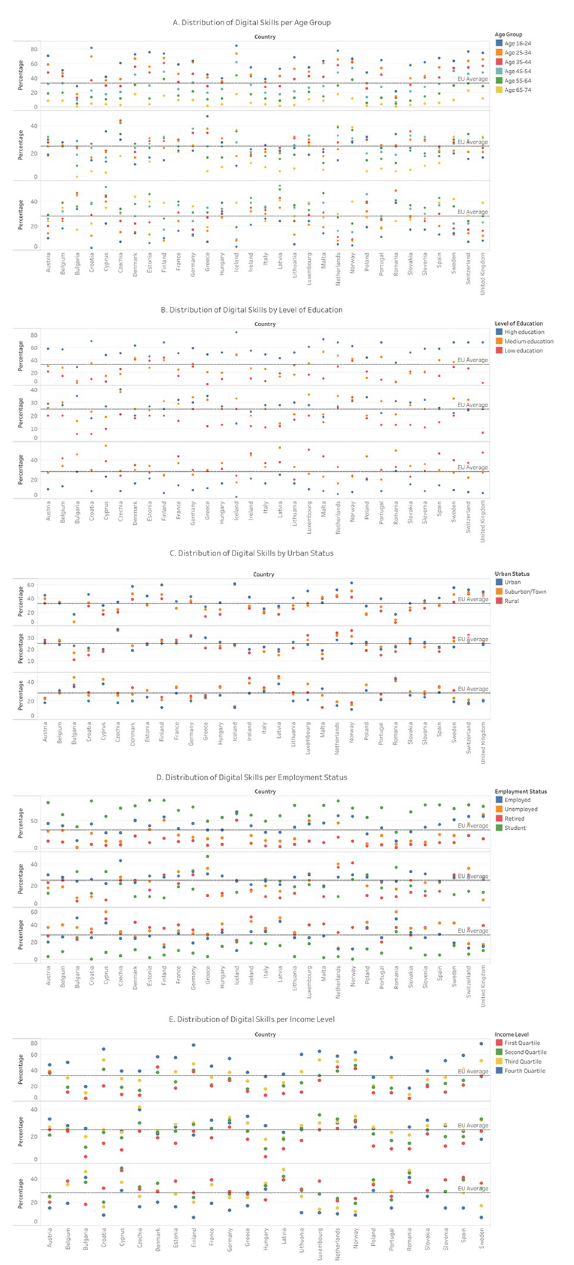
Fig 4. Scatterplot of digital skills across Europe stratified by age (Fig 4A), level of education (Fig 4B), urban status (Fig 4C), employment status (Fig 4D), and income level (Fig 4E). The top plot indicates above basic digital skills, the middle plot basic digital skills, and the bottom plot low digital